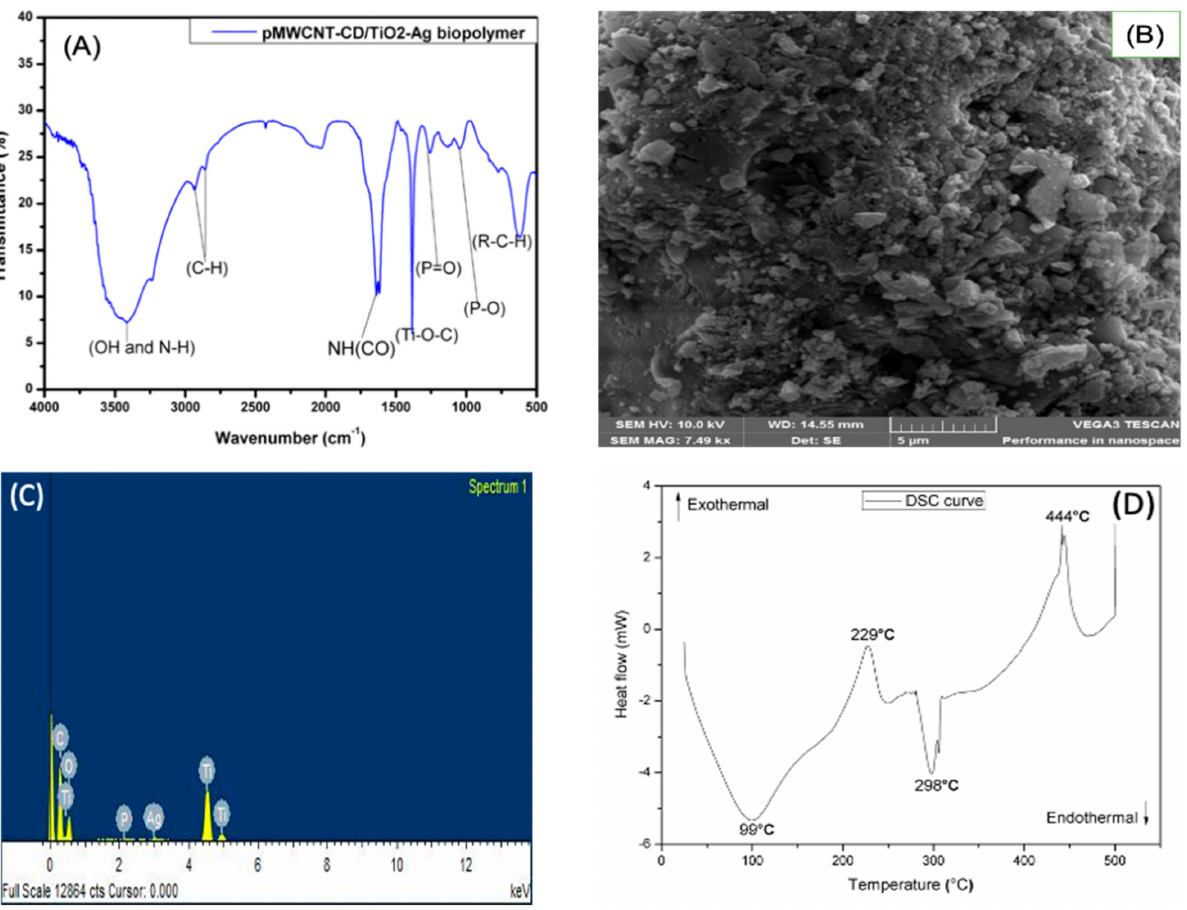
Figure 1. ( A ) FTIR spectrum, ( B ) SEM picture, ( C ) EDX spectrum, and ( D ) DSC curve of the developed nanobiocomposite polymer (pMWCNT/CD/TiO 2